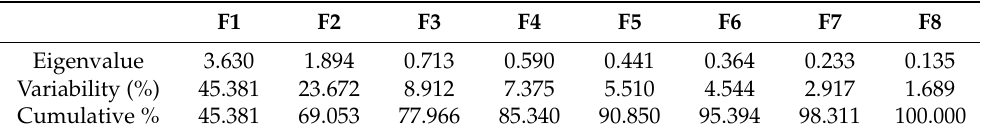
Table 8. Categorizing the eigenvalues of the meaningful biological characteristics. F1 F2 F3